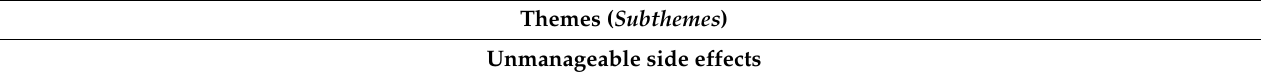
Table 3. Additional quotes from women who